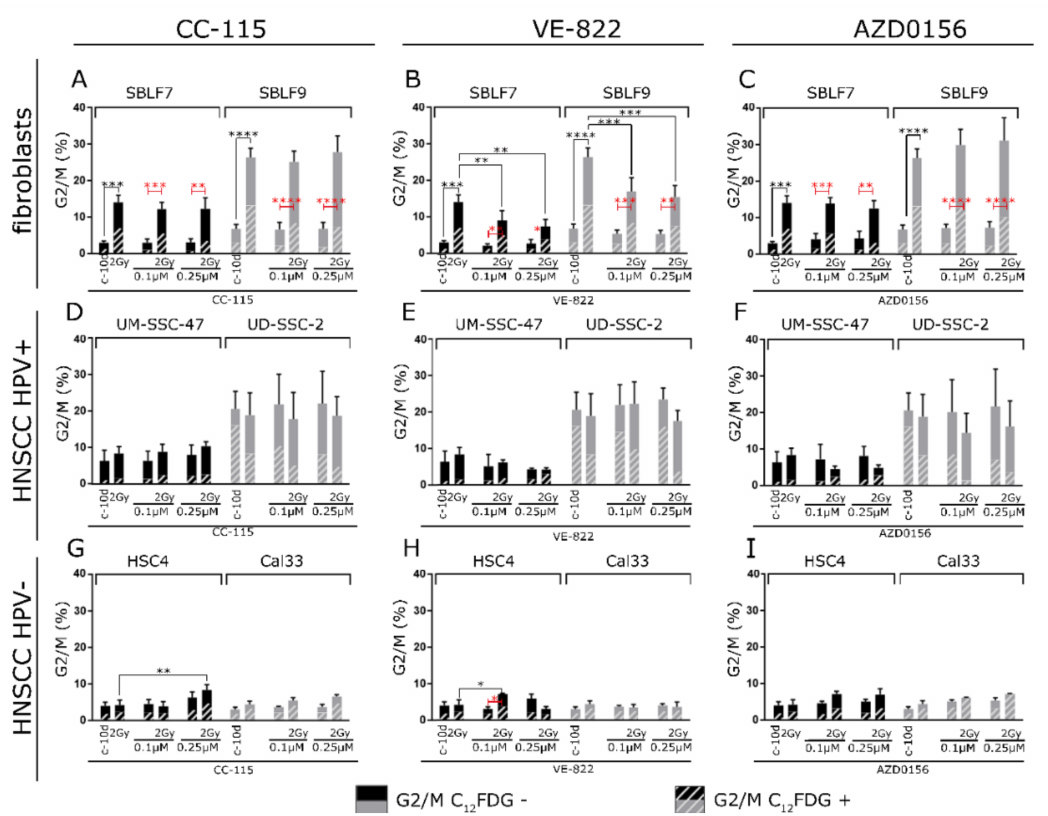
Figure 5. G2 / M phase in two fibroblasts cell cultures, two HPV + and two HPV- HNSCC cell lines. Distribution of C 12 FDG positive and C 12 FDG negative cells among the G2 / M cells. Cells were treated by 2 Gy IR alone, kinase inhibitor alone, or combined kinase inhibitor and 2Gy IR. Fibroblasts cell cultures SBLF7 and SBLF9 treated with ( A ) DNA-PK and mTor inhibitor CC-115, ( B ) ATR inhibitor VE-822, and ( C ) ATM inhibitor AZD0156. UM-SCC-47 and UD-SCC-2 HPV + HNSCC cells treated with ( D ) DNA-PK and mTor inhibitor CC-115, ( E ) ATR inhibitor VE-822, and ( F ) ATM inhibitor AZD0156. HSC4 and Cal33 HPV- HNSCC cells treated with ( G ) DNA-PK and mTor inhibitor CC-115, ( H ) ATR inhibitor VE-822, and ( I ) ATM inhibitor AZD0156. Error bars indicate standard deviation for C 12 FDG negative G2 / M cells. Each experiment was repeated three times at least and controls at least five times. p -values shown for Holm–Sidak multiple comparisons test in black and red colors. p -values refer to the whole proportion of G2 / M cells. * p < 0.05; ** p < 0.01; *** p < 0.001; **** p <